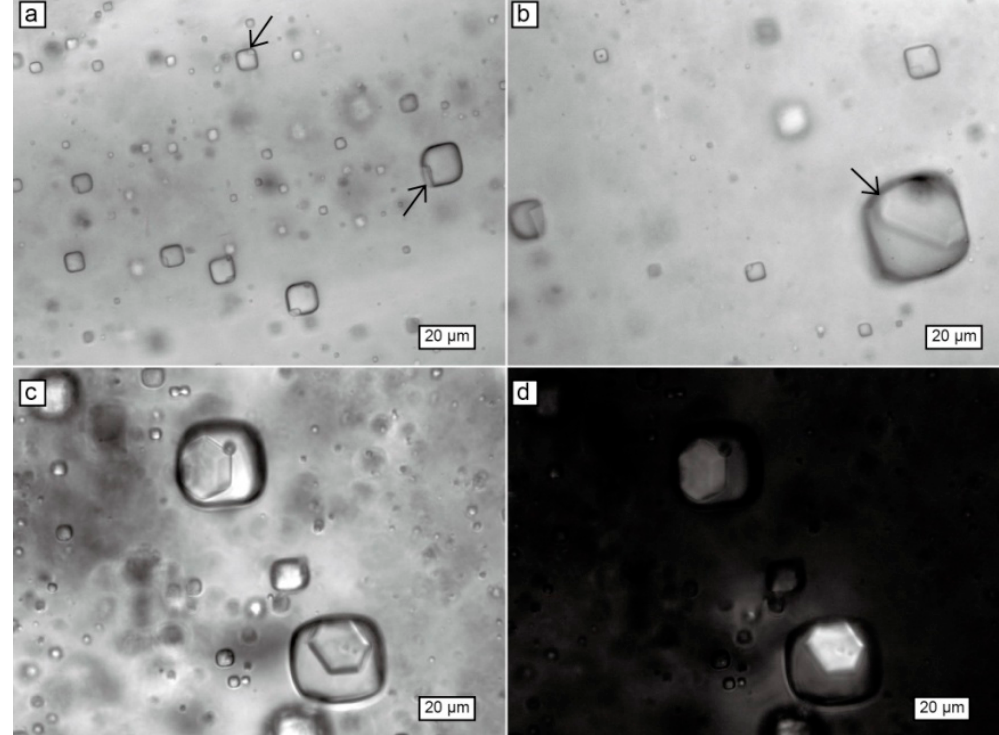
Figure 4. Photomicrographs of daughter crystals in fluid inclusions, Maha Sarakham Formation halite. ( a ) Sylvite daughter crystals (arrows) in fluid inclusion bands. Note the identical solid-liquid ratios in the fluid inclusions. Core K79, 145 m; ( b ) occurrence of sylvite and carnallite (arrow) daughter crystals in adjacent fluid inclusions. Core K79, 145 m; ( c , d ) carnallite daughter crystals (hexagonal, low relief, and birefringent under cross-polarized light) in fluid inclusions from Core RS 2.10, 89 m.